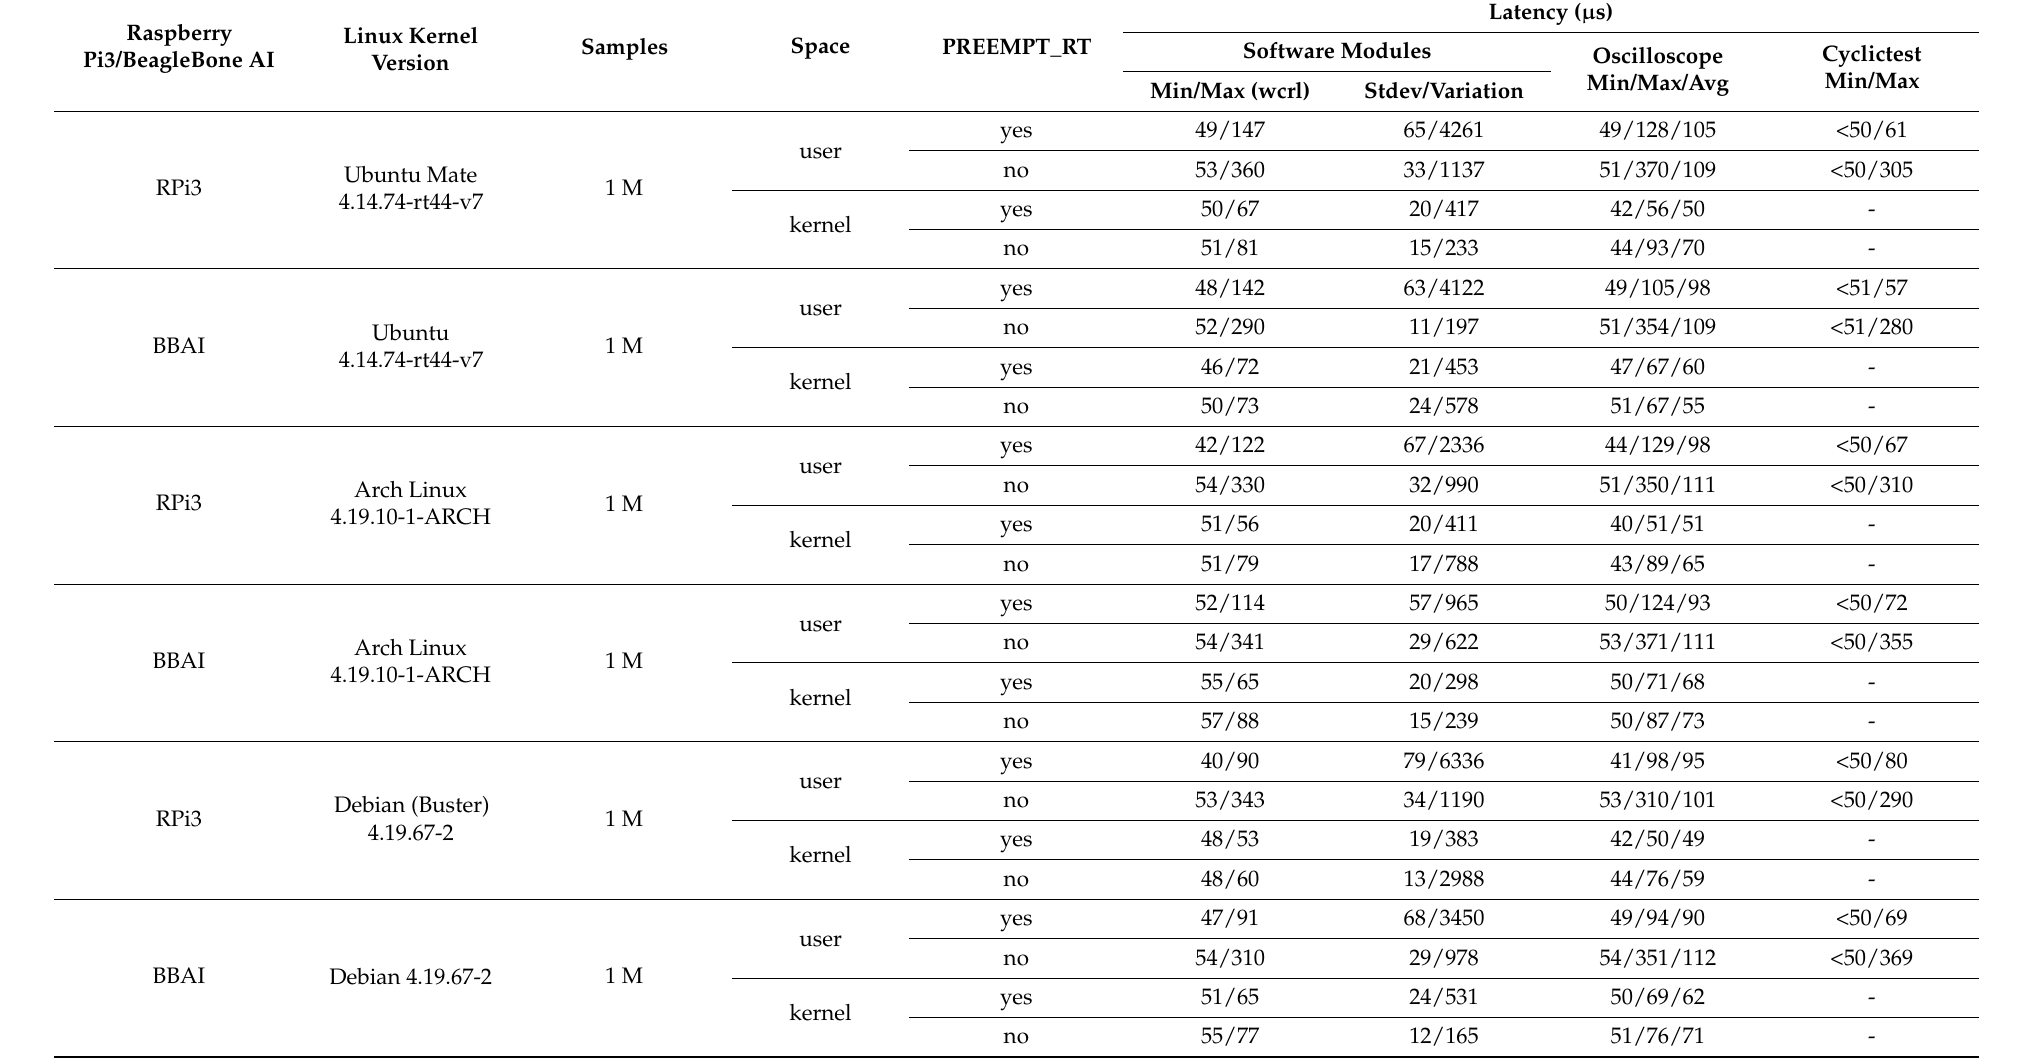
Table 4. Overall response latency results with and without the PREEMPT_RT